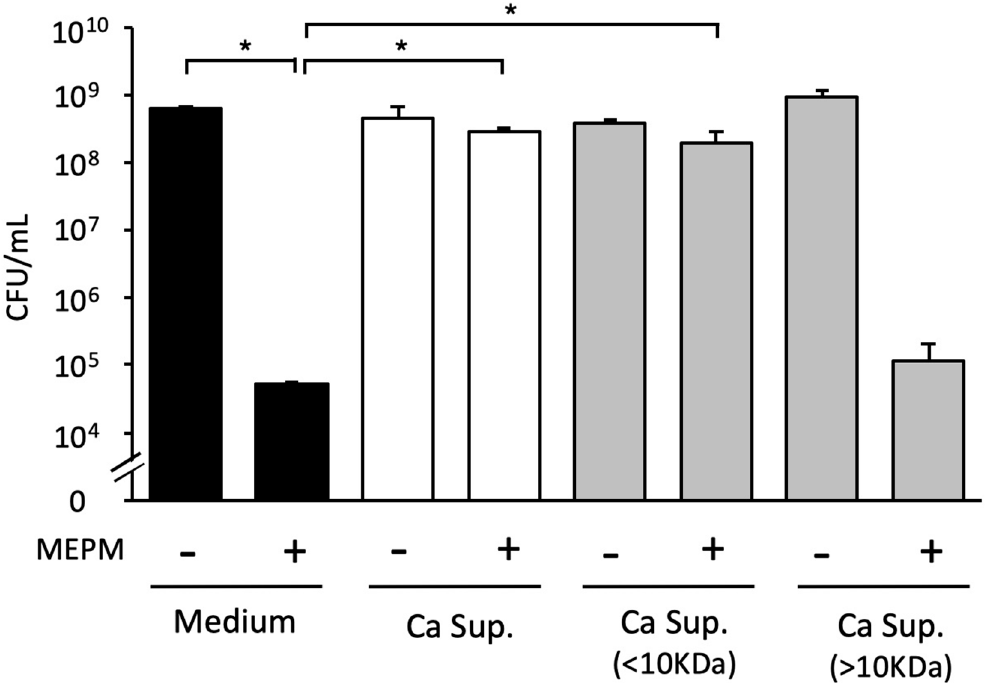
Figure 7. Effects of Candida culture supernatant (Ca Sup.) fractions on E. coli biofilm formation. The effects of supernatant fractions containing materials <10 kDa and >10 kDa in size in the presence of 50 μ g/mL MEPM on E. coli survival. The measurements were performed three times, and the data are presented as the mean ± standard deviation. n = 3/group. Statistically significant differences between groups were evaluated using Tukey’s test with one ‐ way ANOVA; * p < 0.05.